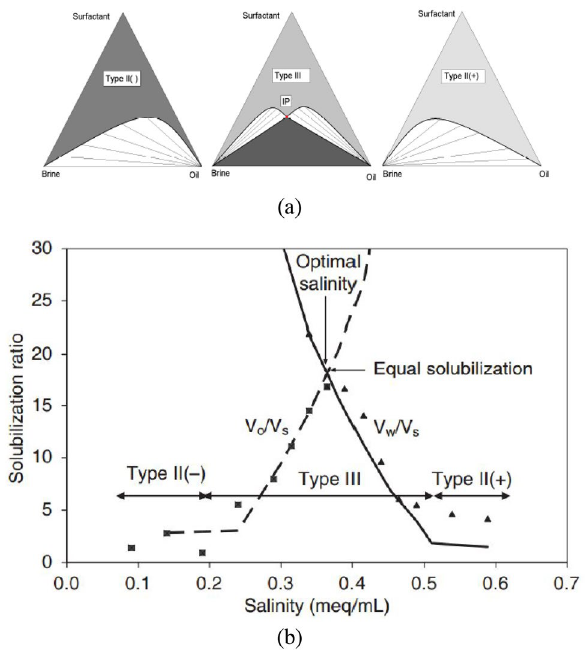
Figure 1. Types of microemulsions at different salinities ( a ) Microemulsion phase ternary diagrams at increasing salinity. ( b ) Solubilization ratio for oil and water for various salinities in a salinity scan 1